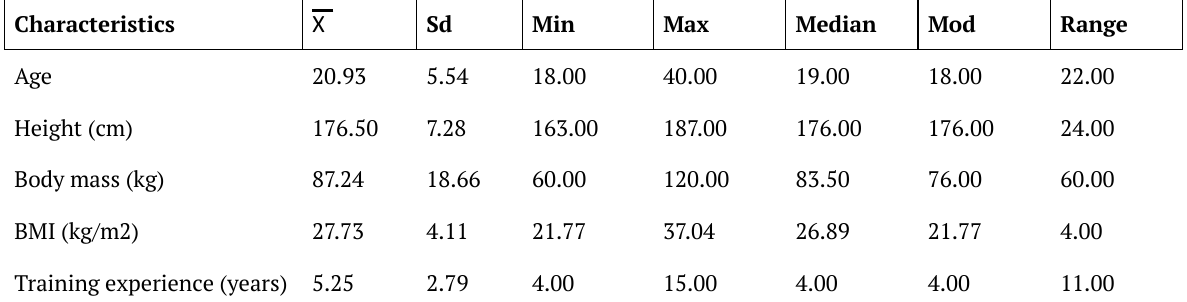
Table 1. Demographic characteristics of the participants